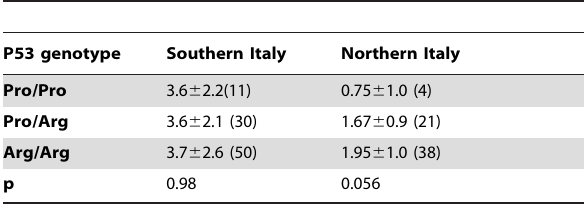
Table 2. Mean number of children ( 6 SD) according to P53 genotype. The number of subjects is given in brackets.